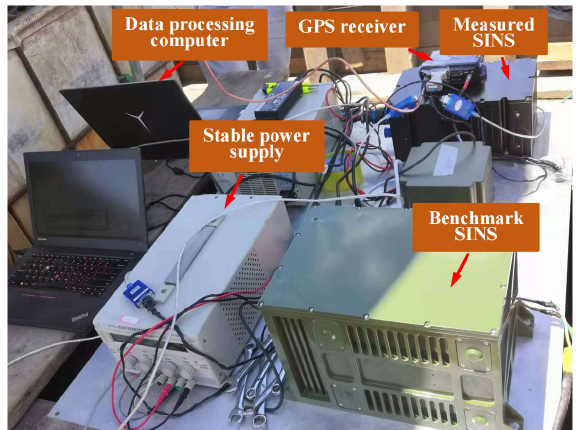
Figure 11. Related equipment required for the test.